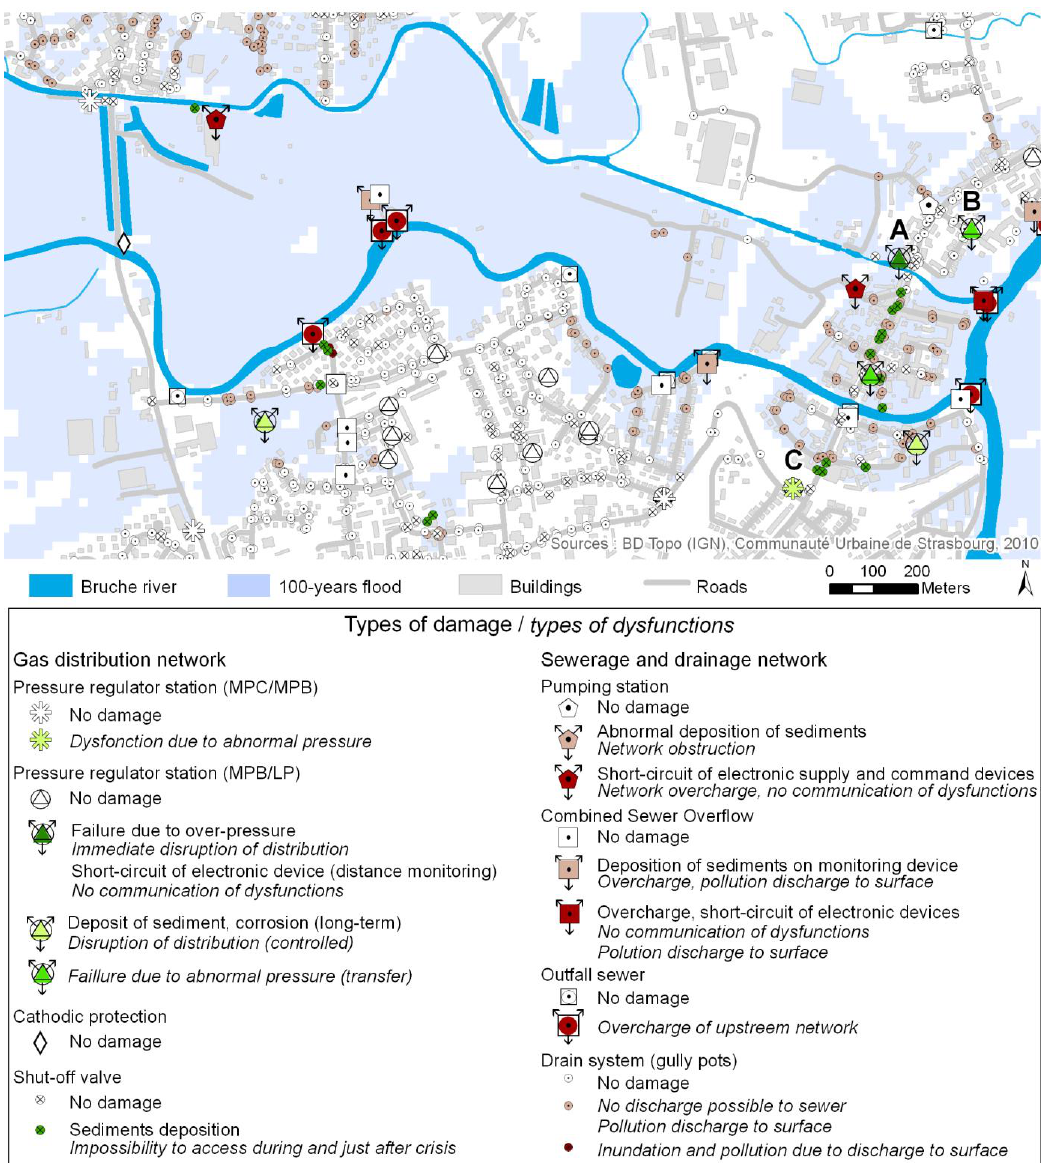
Fig. 6. Map of damage-dysfunctions caused by a 100-year return-period flood for the components of gas distribution and sewerage/drainage